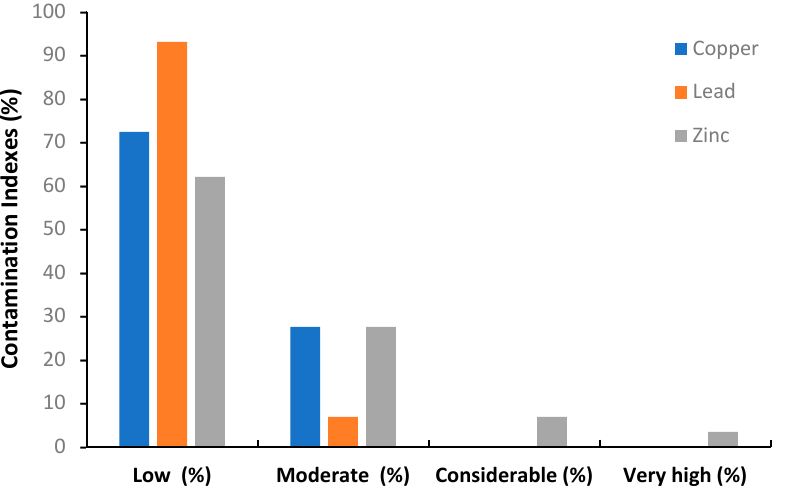
Figure 2. Distribution of the market gardens of Lubumbashi according to the contamination factors.